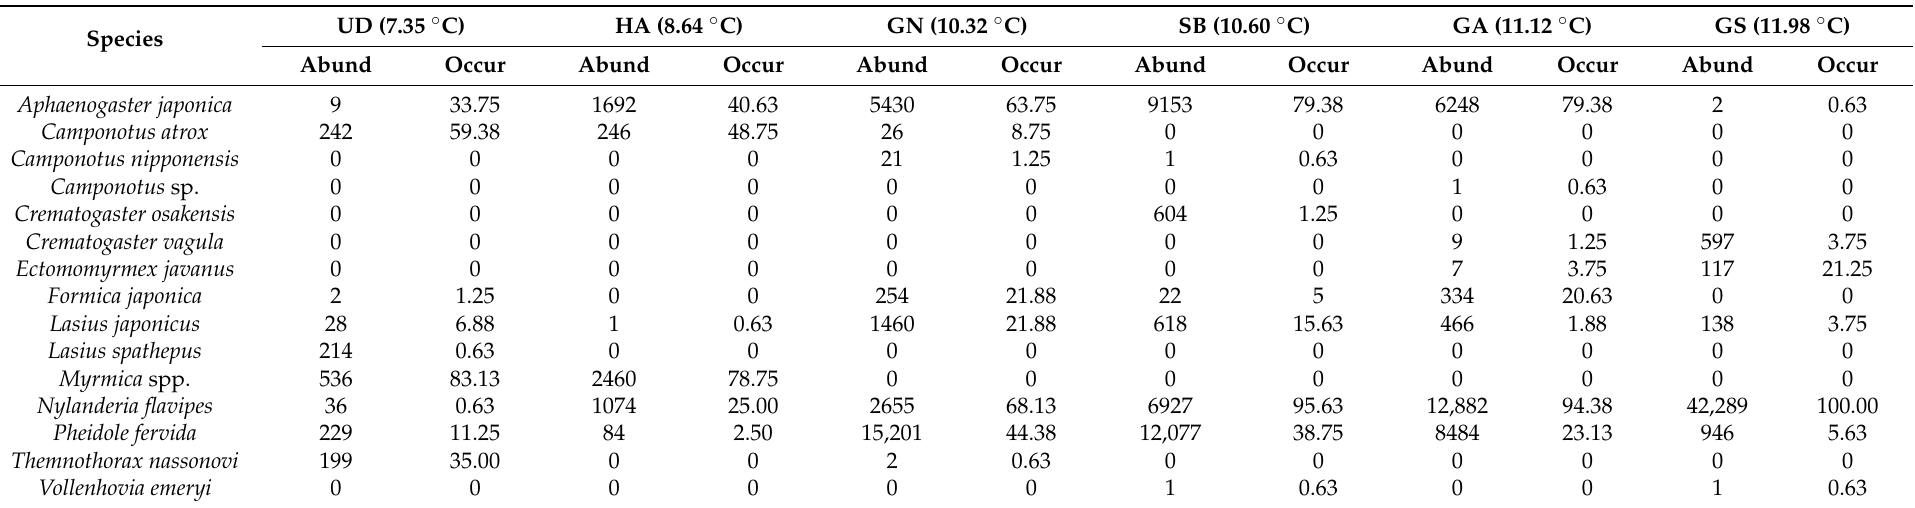
Table 1. Abundance (number of individuals) and occurrence frequency (percentage of occupied traps) of ants attracted by baits at six different temperature sites in South Korea. Temperature in parentheses is the annual mean temperature at each site. UD: Unduryong, HA: Haanrim, GN: Gwangneung, SB: Sobaeksan, GA: Gayasan, GS: Geumsan, Abund: abundance, and Occur: occurrence